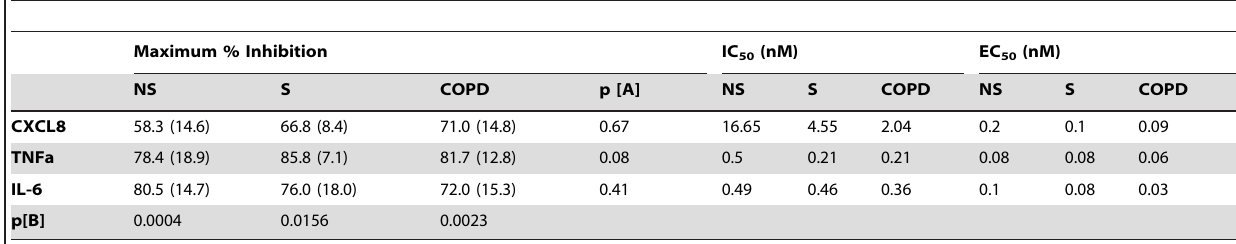
Table 2. Maximum inhibition, IC 50 and EC 50 for the effects of 17-BMP on LPS-stimulated macrophage cytokine production.